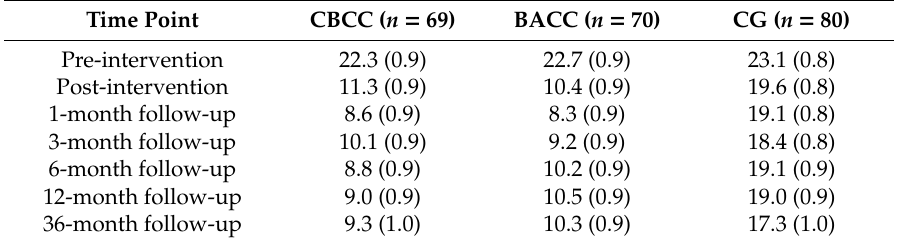
Table 3. Estimated mean scores (and standard errors) for depressive symptoms for the intervention groups and the control group.